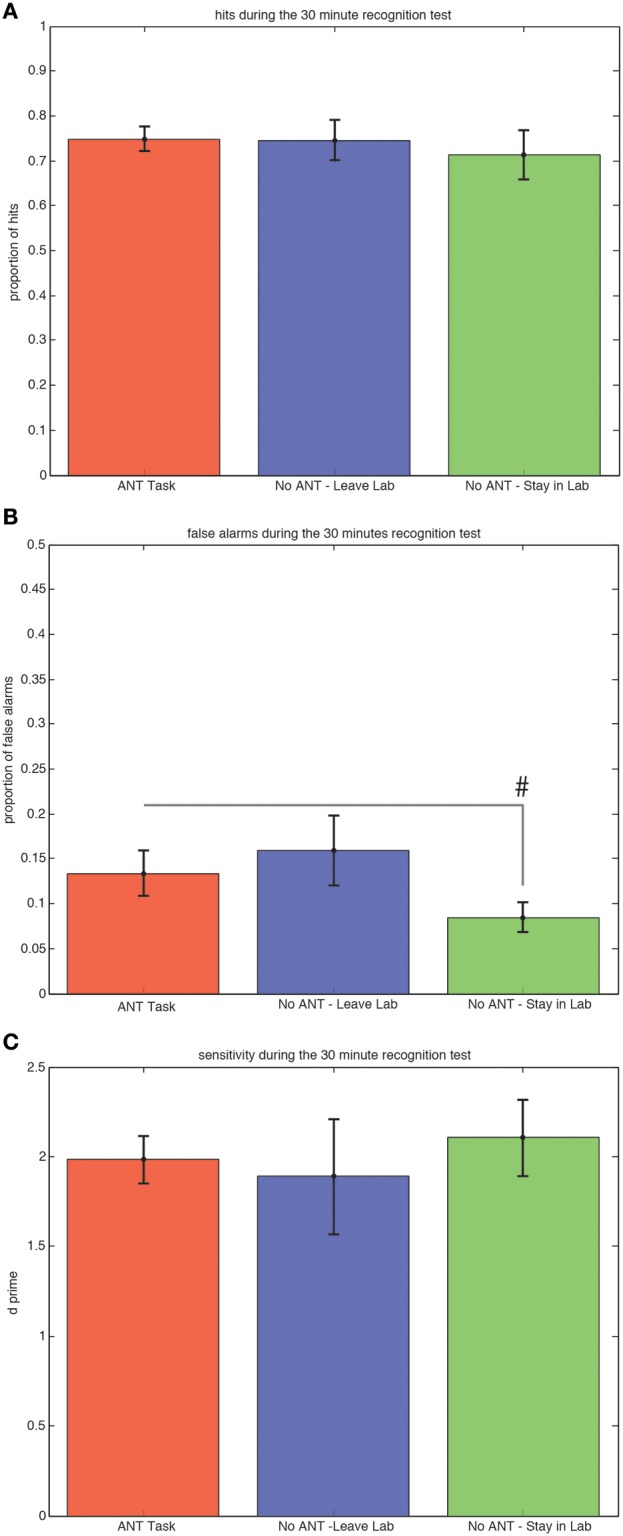
Ability to Discriminate Old from New Scenes at the 30 min Recognition Test is Not Affected by Changing Attention or Context during Awake Offline Processing. Average hits (± SEM) do not differ among groups (A). There is a trend (#p < 0.1) for subjects who remained in the testing room to make fewer false alarms compared to subjects who performed the R-ANT (B). There is no difference in sensitivity (C) among the three groups.